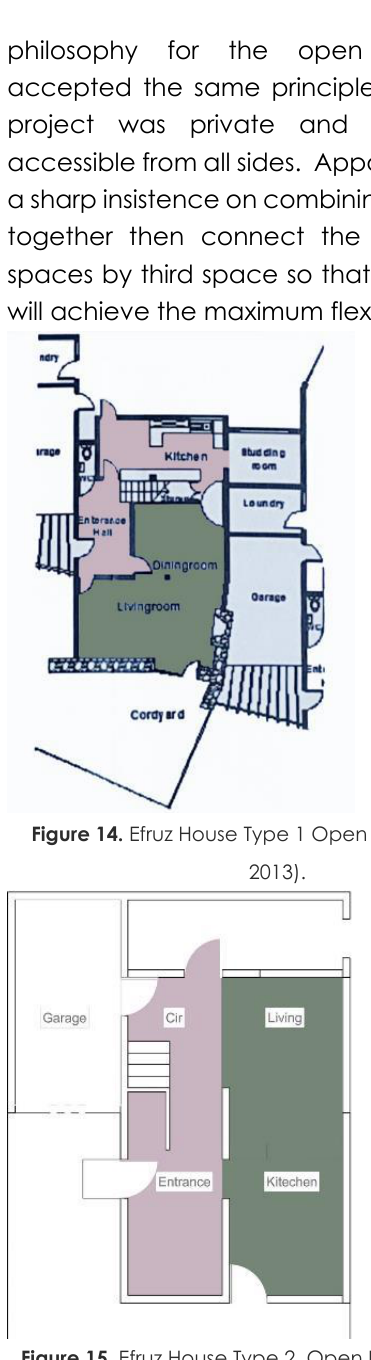
Figure 15 . Efruz House Type 2, Open Plan (Drawing by